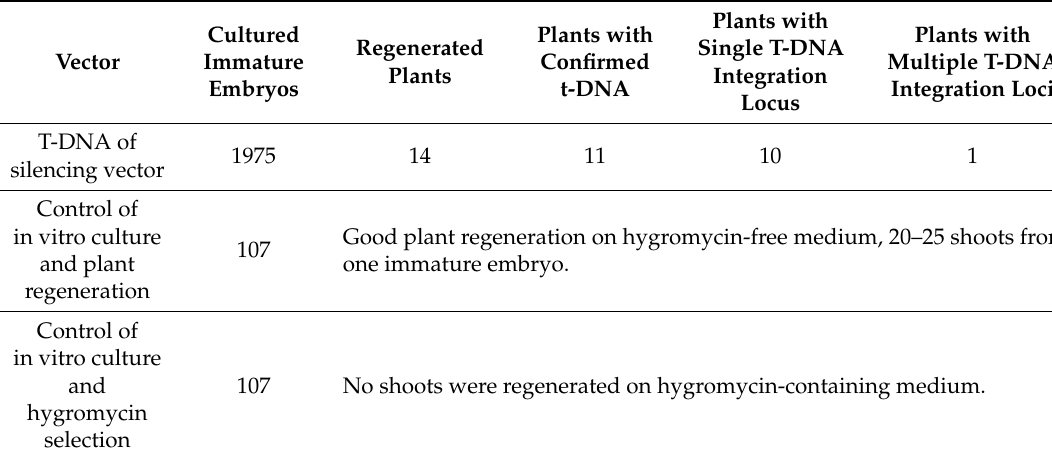
Table 1. Agrobacterium-mediated transformation and in vitro culture of immature barley